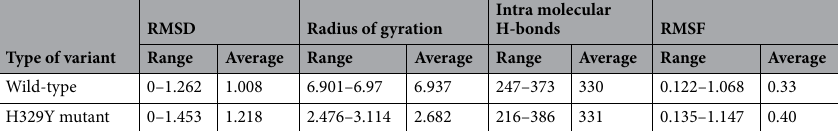
mutant was increased till 36,000 ps but after that time period the RMSD value was stable and showed a constant peak. The wild-type of GATA6 with an RMSD of about 1 nm was stabilized, while RMSD values of the H329Y mutant were higher than wild-type it was stabilized with an RMSD of about 1.3 nm. The result suggested that the H329Y mutant is unstable compared to the wild-type of GATA6 .